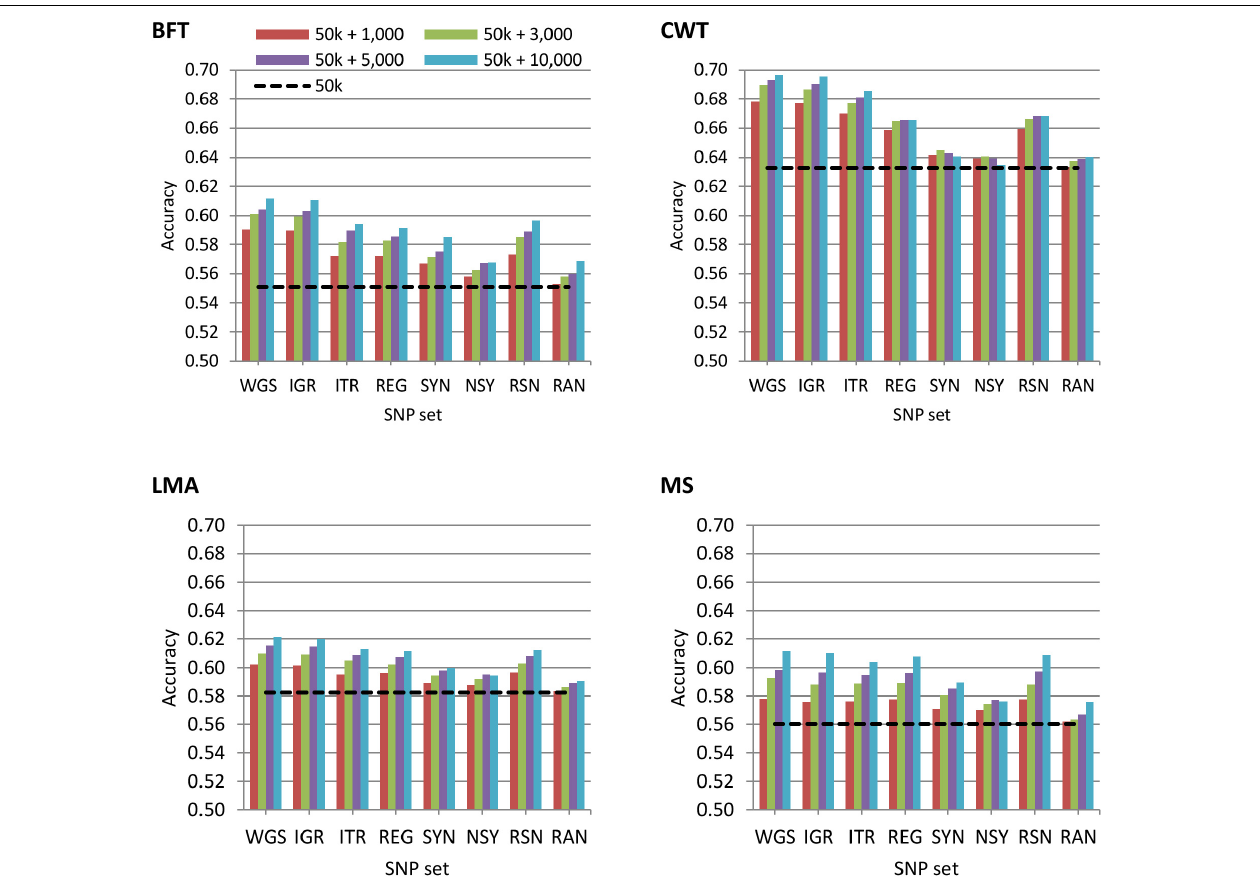
FIGURE 1 | Accuracy of genomic predictions using the 50 k SNP panel with trait-specific pre-selected variants from different genomic regions. The added variants to the 50 k panel have different densities of 1,000, 3,000, 5,000, or 10,000. The black dashed line indicates the accuracy of prediction using the 50 k SNP panel only. The traits were backfat thickness (BFT), carcass weight (CWT), longissimus muscle area (LMA), and marbling score (MS). Whole-genome sequence (WGS); intergenic (IGR); intron (ITR); regulatory (REG); synonymous (SYN); non-synonymous (NSY); combination of regulatory, synonymous, non-synonymous (RSN); and randomly selected from WGS